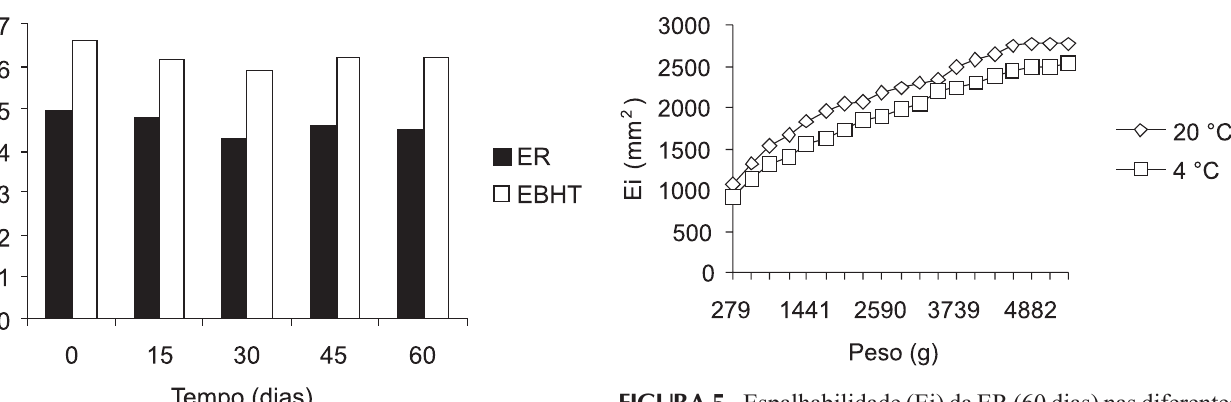
FIGURA 5 - Espalhabilidade (Ei) da ER (60 dias) nas diferentes condições de armazenamento em relação ao peso adicionado